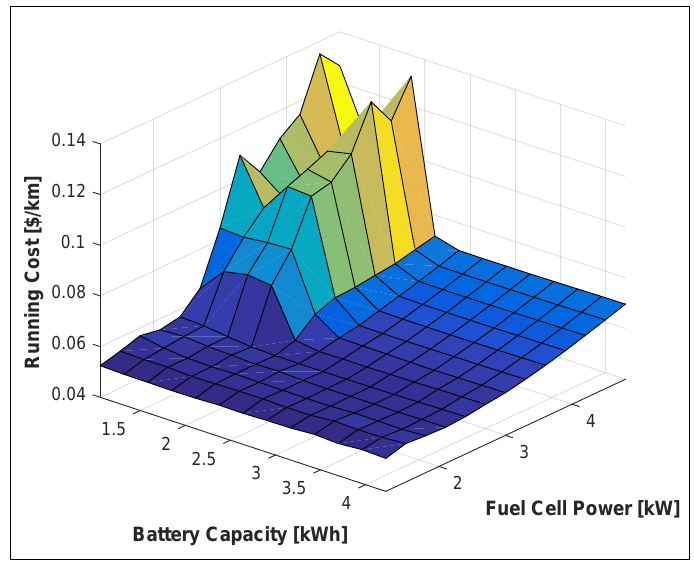
Figure 9. Running cost.